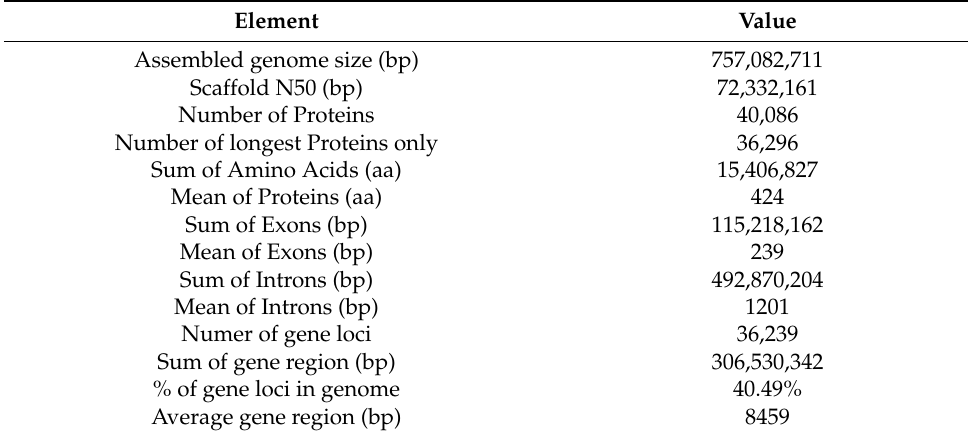
Table 2. Statistics on gene model annotation of M. hongkongensis .